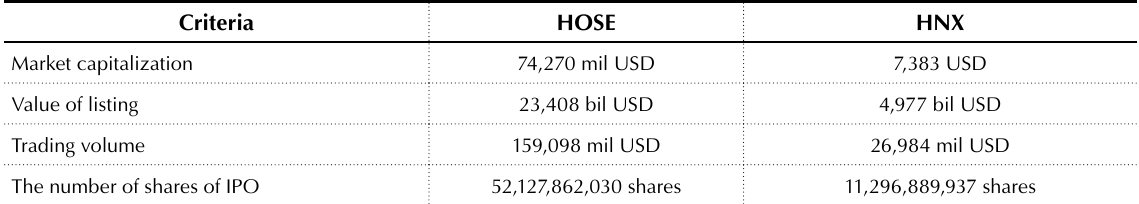
Table 1. Hochiminh and Hanoi stock exchanges in